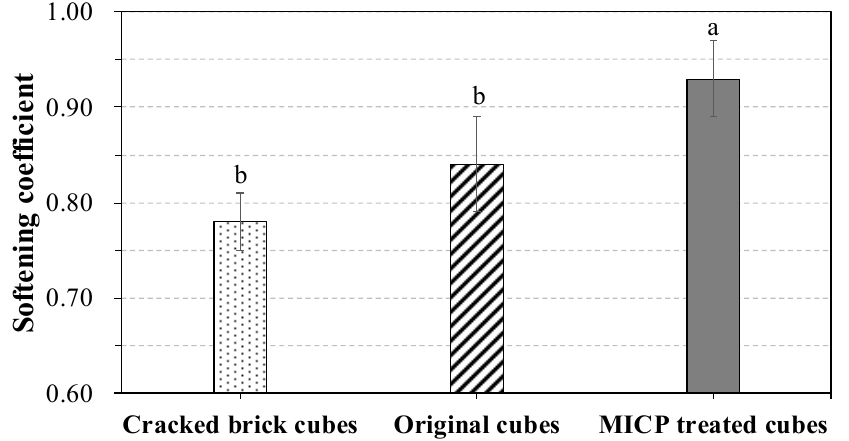
Figure 4. Softening coefficient for brick cubes with MICP treatment. Each measurement represents the mean of three replicate samples and bars indicate standard deviation. Different letters above the bars represent significant difference at the 0.05 level.